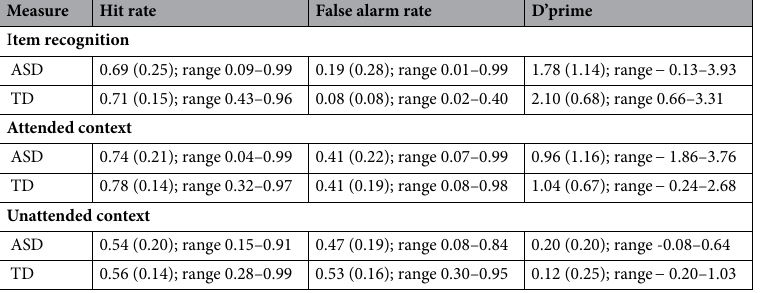
Table 2. Group averages in hit rate, false alarm rate, and discriminability (d’) for item and context memory. Note. Mean (Standard